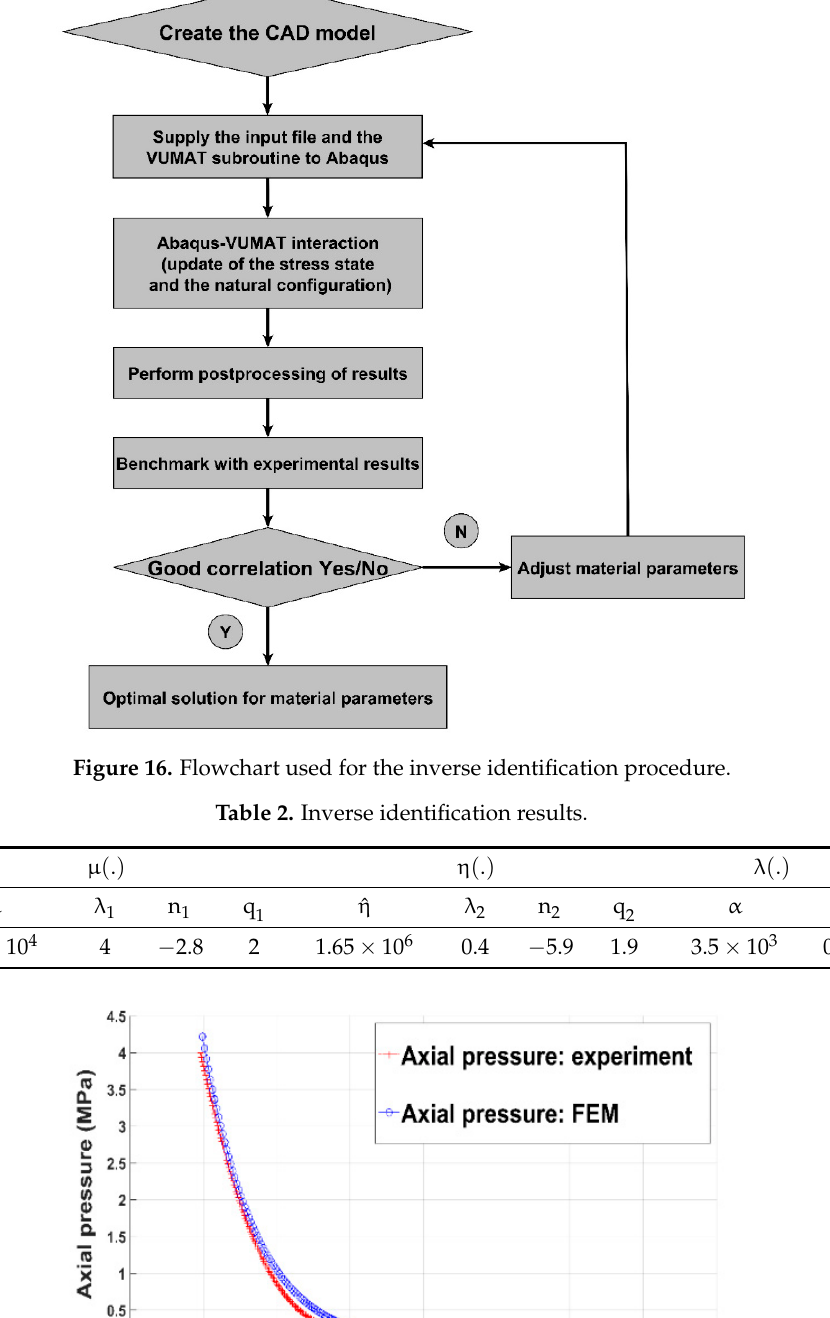
Figure 18. Radial pressure: FEM vs. experiment. Figure 19. Circumferential strain at the mold wall: FEM vs. experiment.